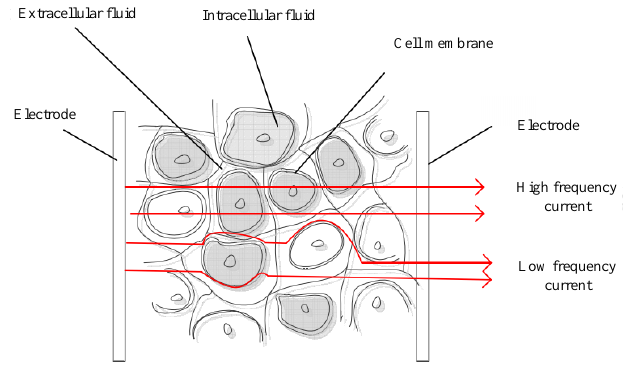
Figure 1. Conductive pathways of high-frequency and low-frequency currents in biological tissues.